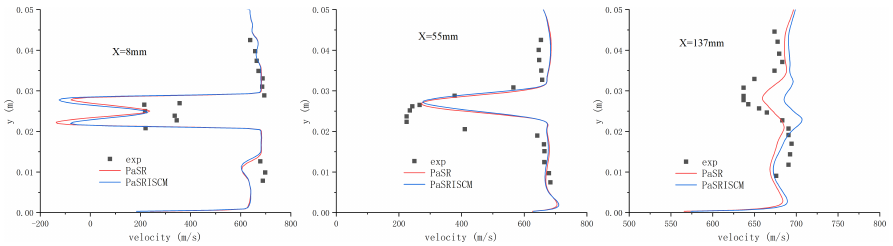
Figure 16. Averaged streamwise velocity profiles compared with experimental results at three locations using different combustion